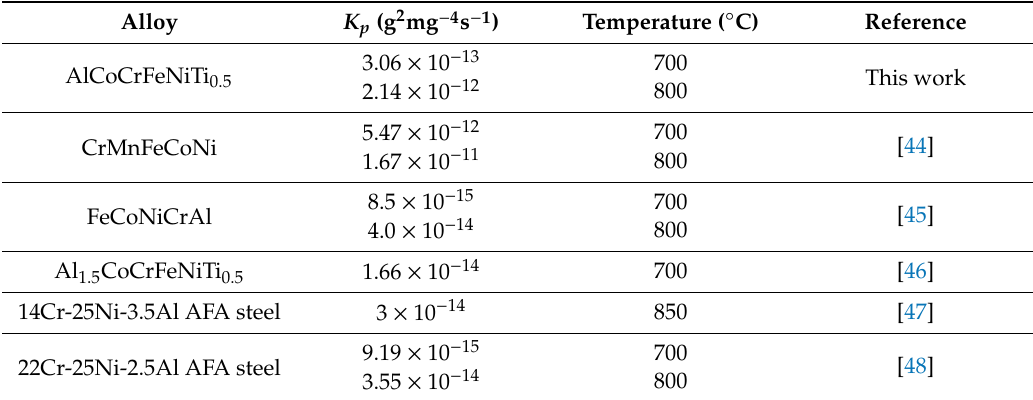
Table 4. The values of the parabolic constants for various